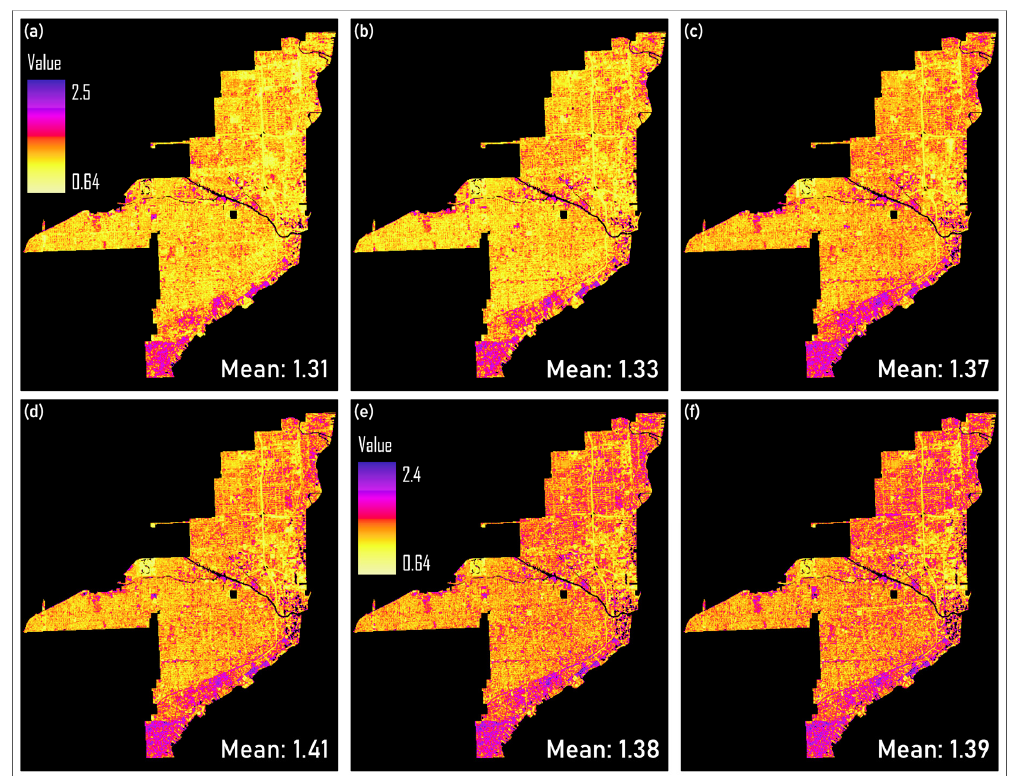
Figure 7. BAEI change detection time-series, giving mean index values, derived from Landsat data; ( a ) 5 TM 11/02/85, ( b ) 11/06/98, ( c ) 11/20/03, ( d ) 11/10/11, ( e ) 8 OLI 10/17/14, ( f ) 10/22/16.